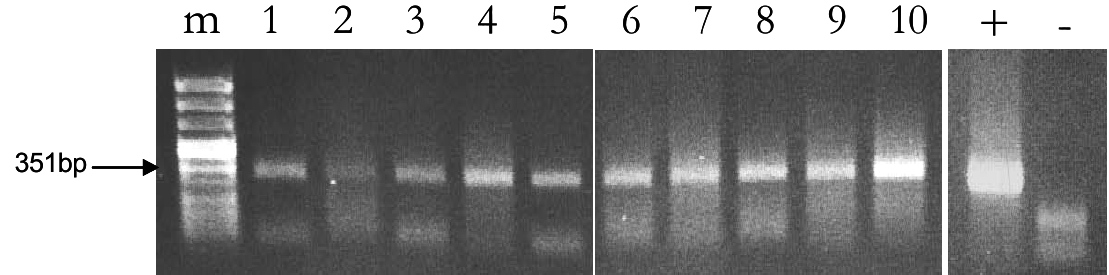
Figure 3. Detection of the 351 bp long rubisco fragment in total DNA extracted from raw cow milk samples of two different stock farms. Lane from 1 to 5: PCR reactions run on 400 ng of total DNA from plain-derived milk sample n° 9; lane from 6 to 10: PCR reactions on 400 ng of total DNA from mountain-derived milk sample n° 4. m: molecular marker; “+”: plant DNA PCR positive control; “-”: negative PCR control (just